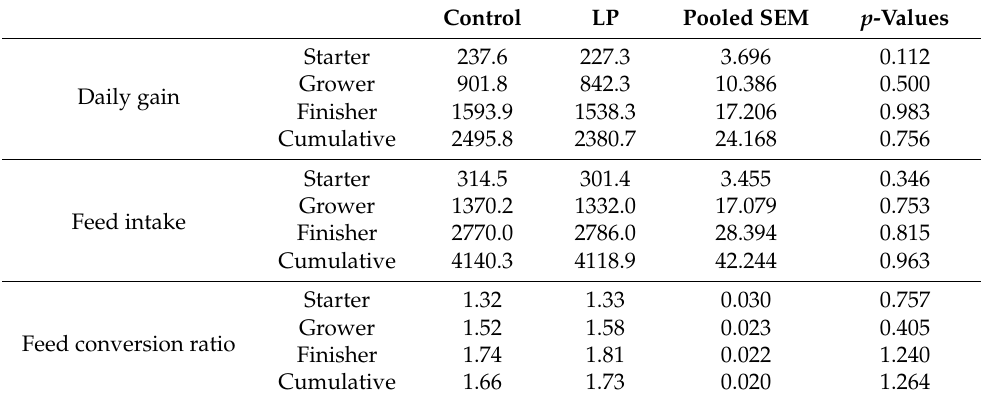
Table 3. Effects of dietary treatments on the performance parameters of broiler chickens. Control LP Pooled